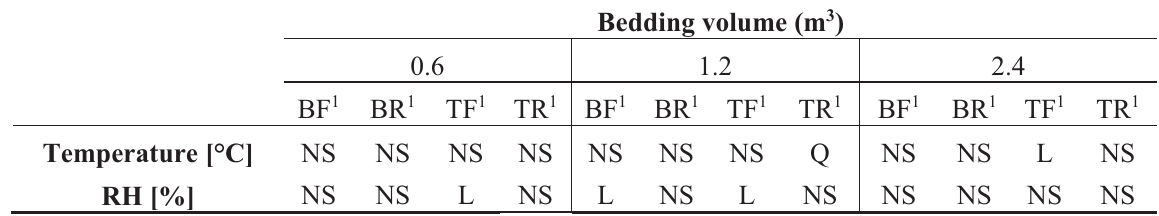
1 BF = bottom front, BR = bottom rear, TF = top front, TR = top rear compartments. Note: Significant Temperature and relative humidity over time (either linear or quadratic) have been plotted in Figures 7 and